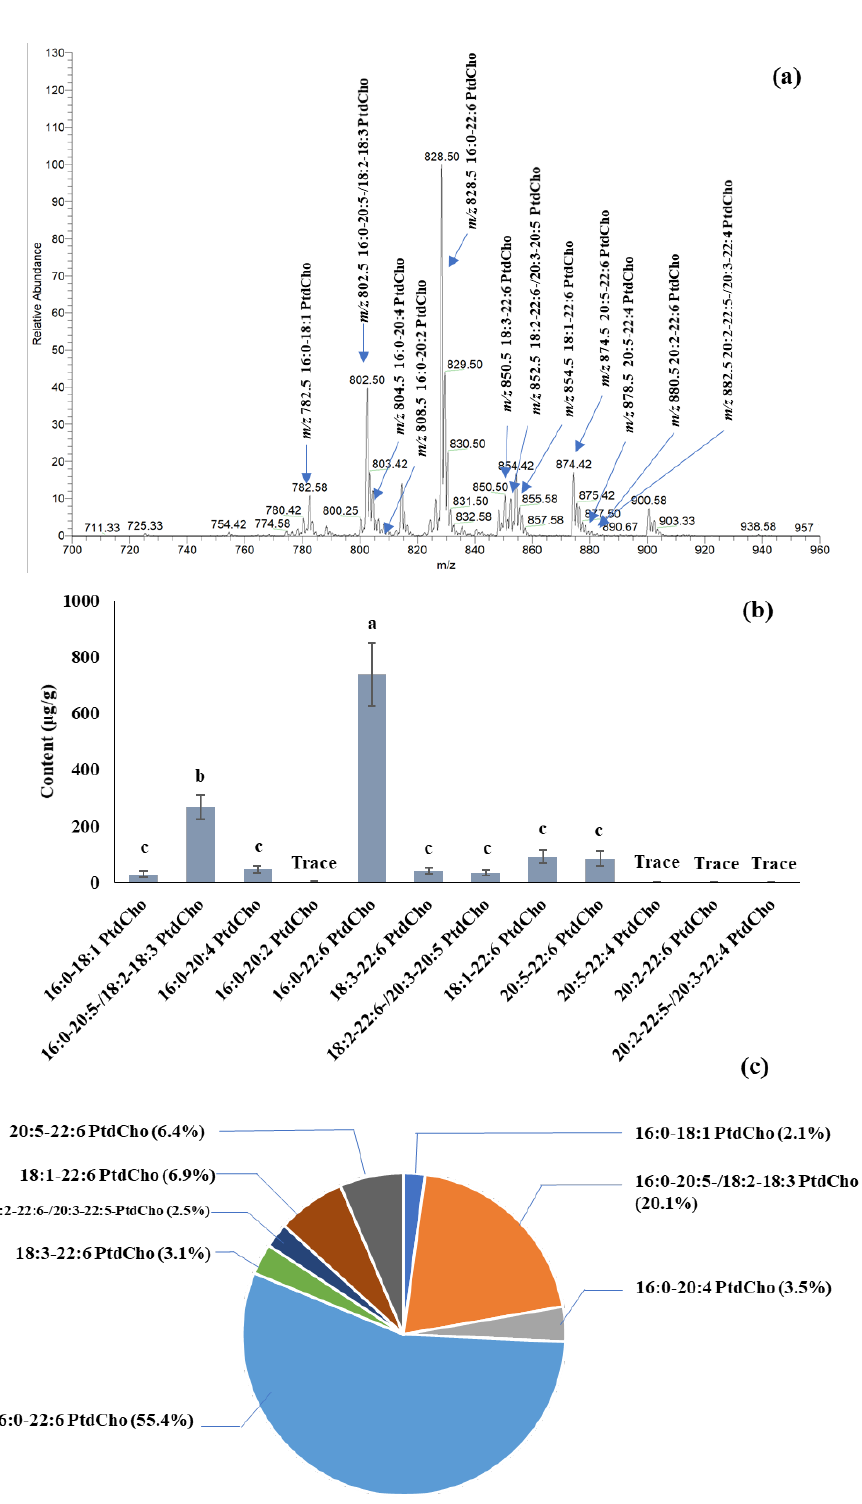
Figure 2. Identification and quantification of phosphatidylcholines (PCs) in salmon muscle tissue. ( a ) Mass spectrum at NL 183.1 and identified PC species in salmon muscle tissue; ( b ) quantification of individual PCs 1 (error bars presented in Figure 2b indicate standard deviation calculated from three independent replicates); ( c ) proportion of each PC species in salmon muscle tissue. 1 Values having the same letter are not significantly different ( p > 0.05). The different letters (i.e., a, b, c, etc.) indicate significant differences among values, and the largest value is denoted as “a”.